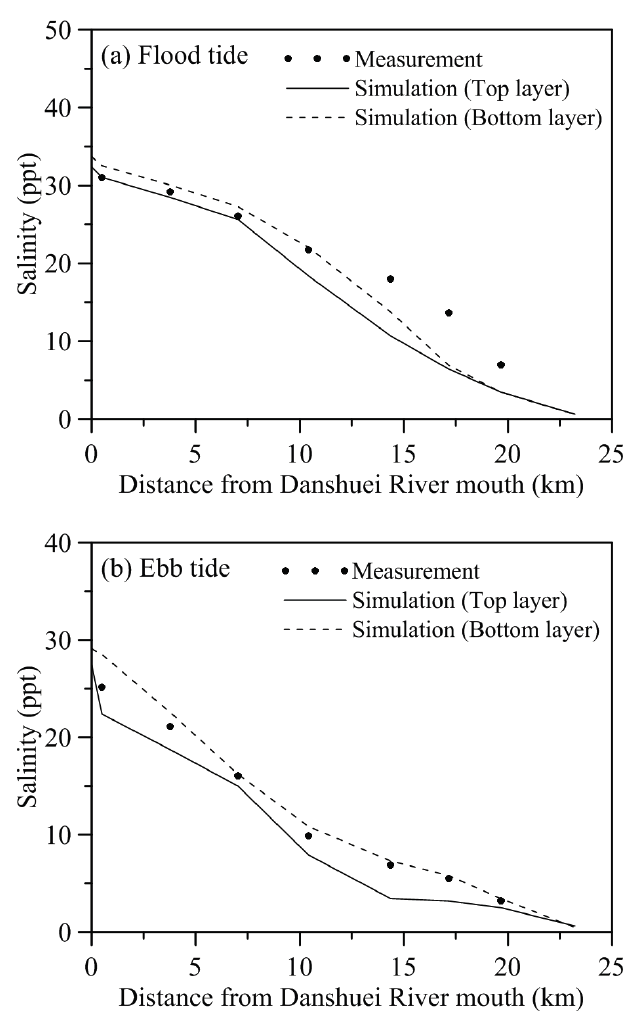
Figure 4. Comparison between measured and simulated salinities along the Danshuei River-Tahan Stream on 26 November 2010, during the ( a ) flood tide and ( b ) ebb